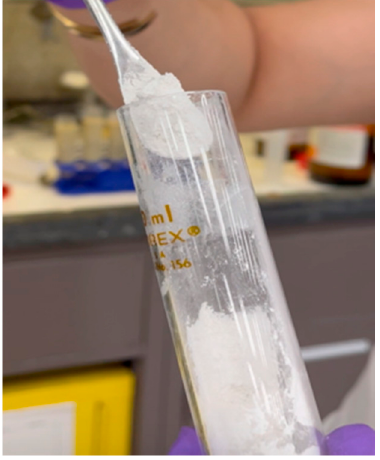
Figure 5. WBB06 cells dried down after drying under the hood.